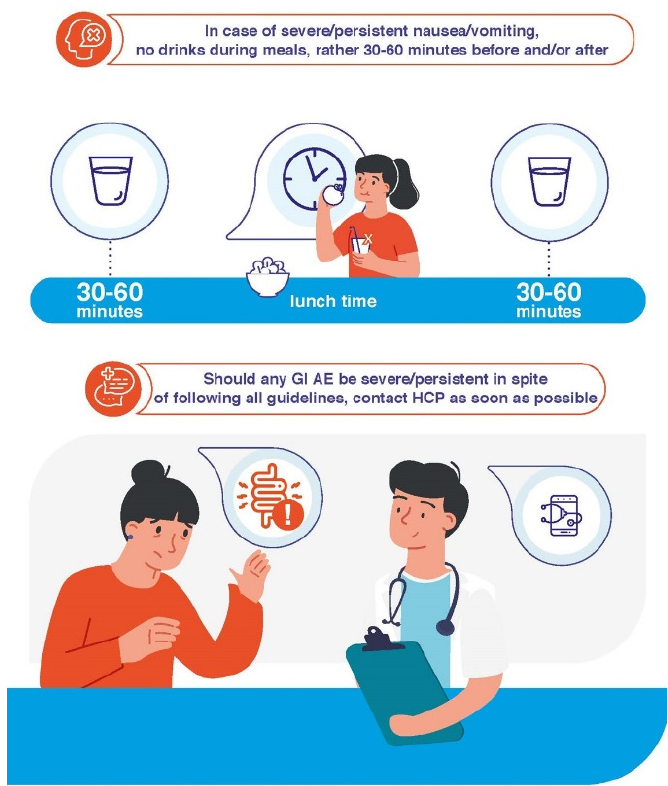
Figure 3. Additional specific guidelines for unusually severe/persistent GI AEs.